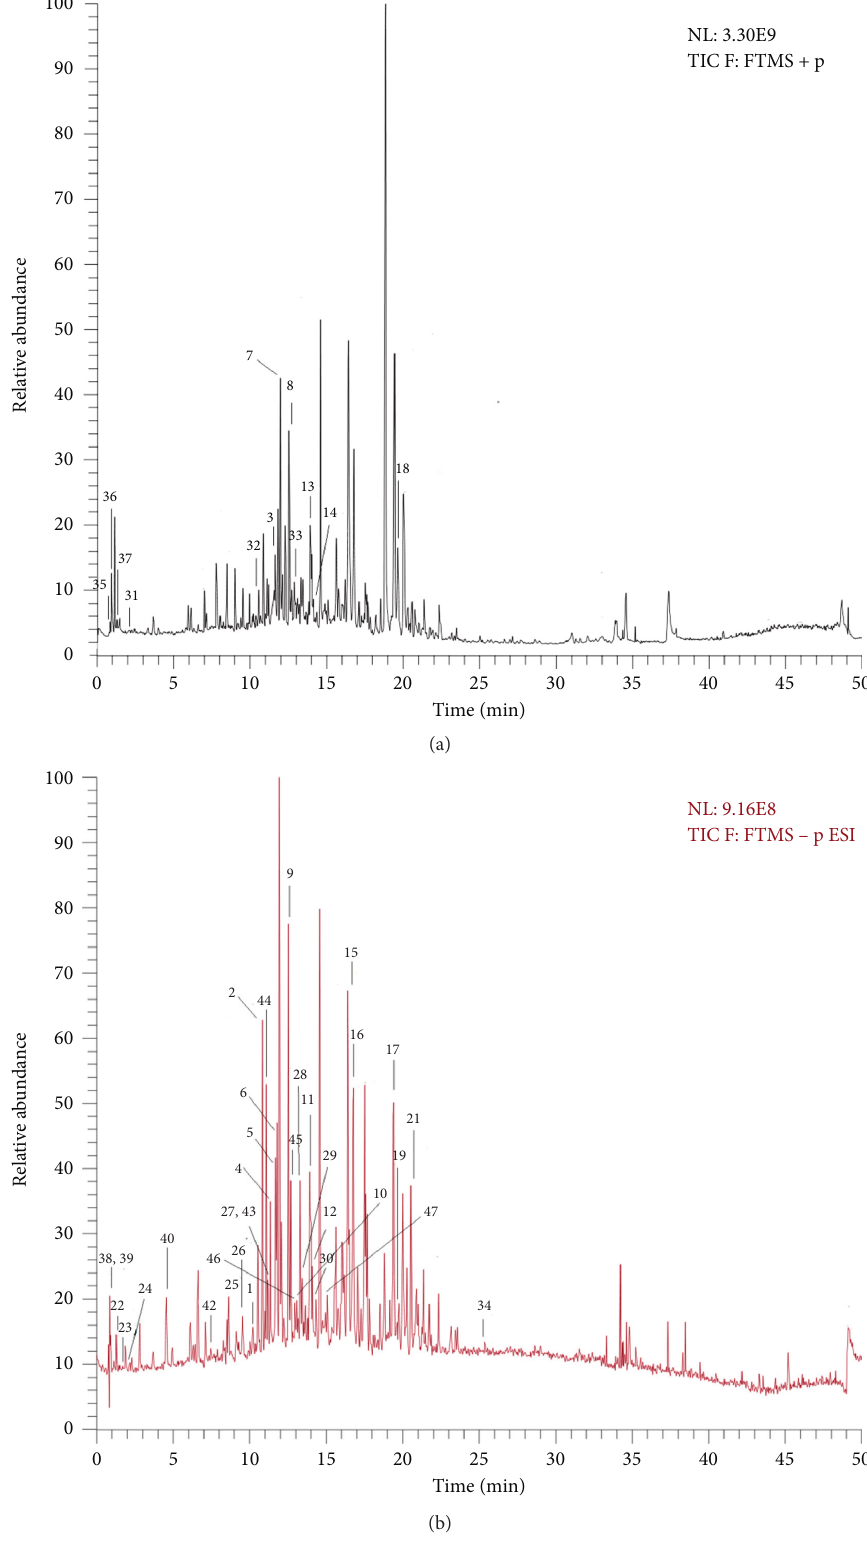
Figure 1: The total ion current chromatogram in positive (a) and negative ions (b). Mode for ethyl acetate of Zhideke